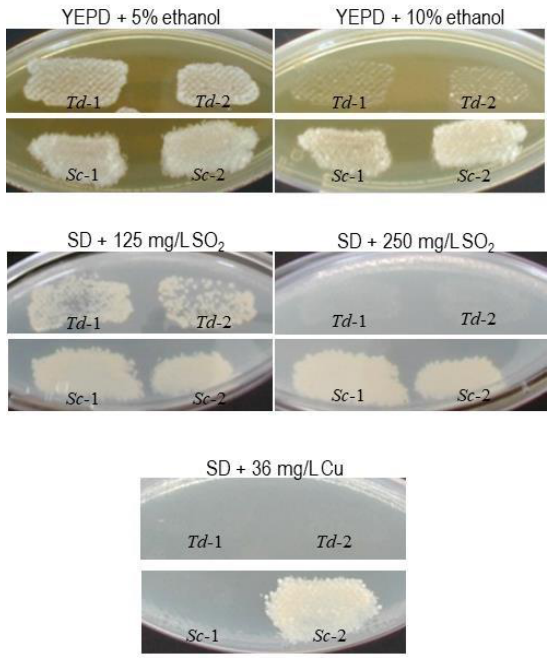
Figure 2. Resistance of T. delbrueckii (Td) and S. cerevisiae (Sc) to ethanol, SO 2 , and Cu. Two strains of each yeast species are shown (Td-1 and Td-2, and Sc-1 and Sc-2, respectively). YEPD: rich YEPD medium. SD: minimal SD medium.